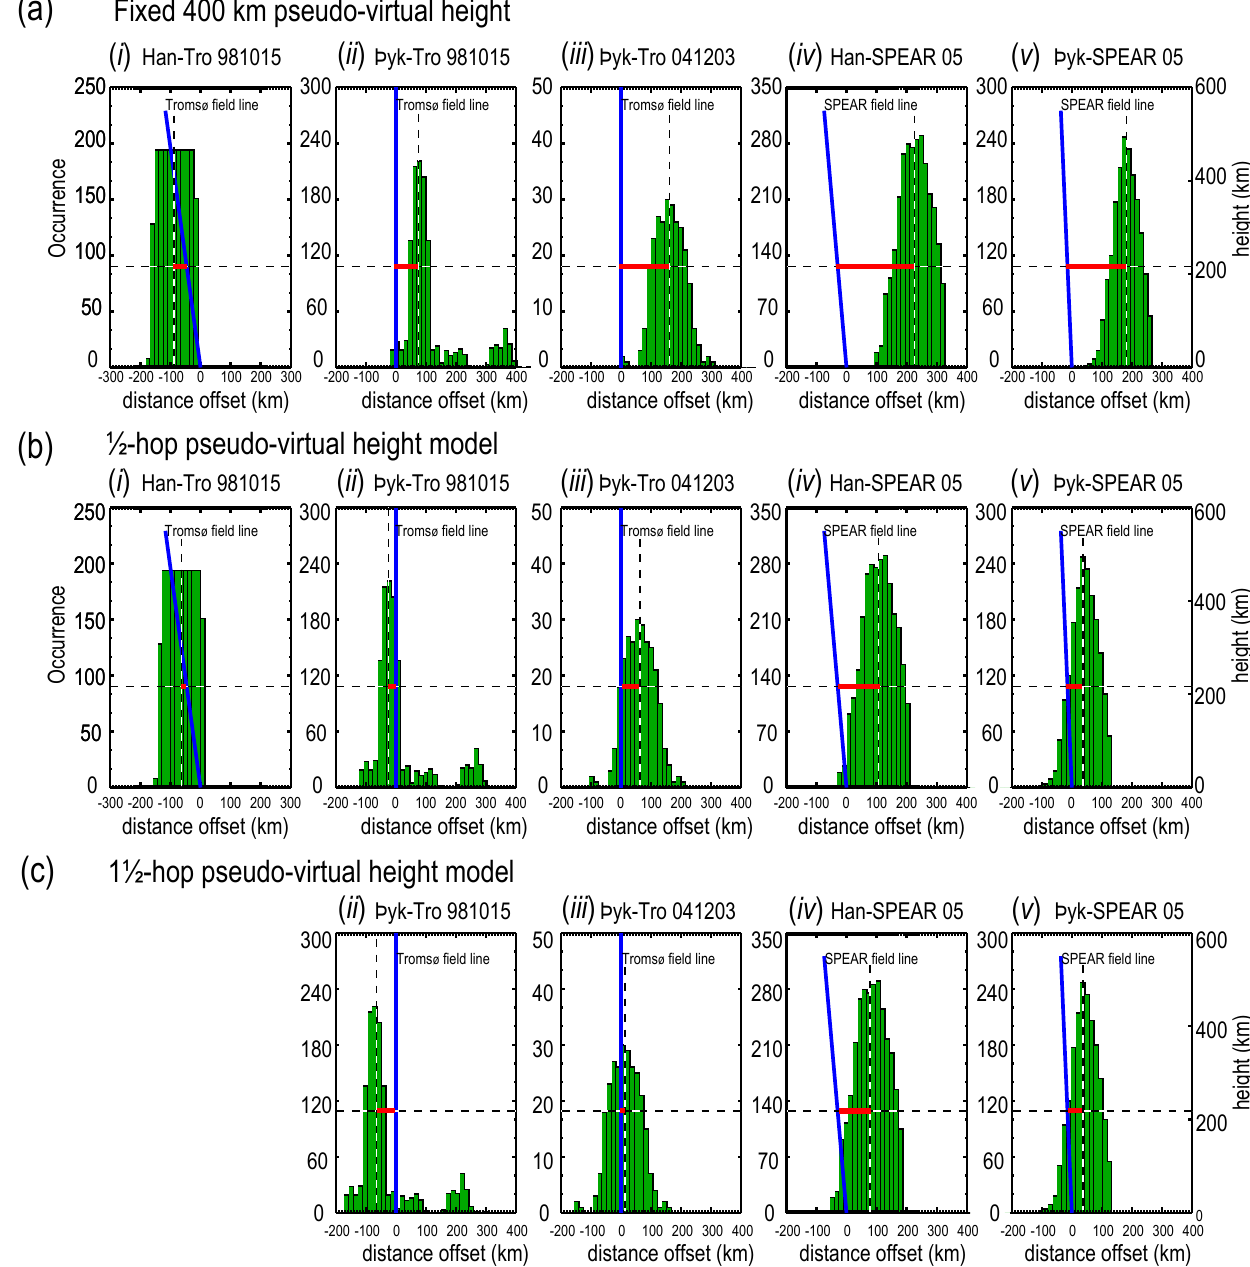
Fig. 4. Occurrence rates for artificial backscatter detection at a power of > 10dB for: column i) Hankasalmi-Tromsø in 1998 column ii) Þykkvibær-Tromsø in 1998; column iii) Þykkvibær-Tromsø in 2004; column iv) Hankasalmi-SPEAR in 2005; column v) Þykkvibær- SPEAR in 2005. Row (a) presents data using the standard SuperDARN virtual height model, row (b) presents the new 1 -hop virtual height 2 model of Chisham et al. (2008), and row (c) presents the new 1 1 -hop virtual height model of Chisham et al. (2008). In each panel the centre 2 of the occurrence histogram is marked by a vertical dashed line, the irregularity height is marked by a horizontal dashed line, and the offset between the centre of the data occurrence histogram and the actual irregularity location on the SPEAR or Tromsø field line is highlighted with a horizontal red